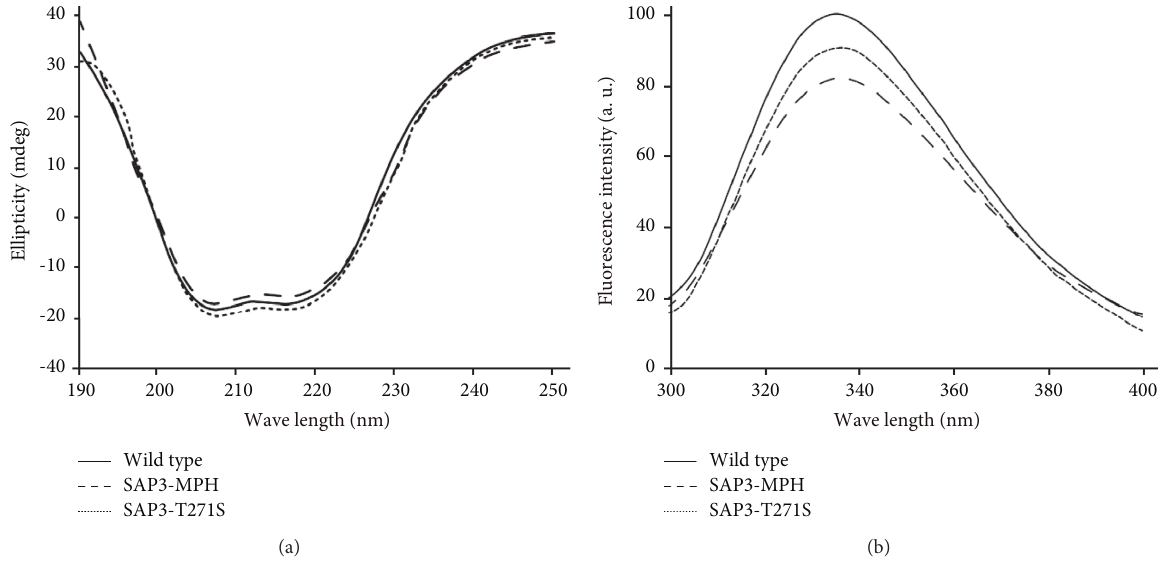
Figure 5: The effect of SAP fusion on the structure of the MPH mutants. (a) CD spectrometry. (b) Steady-state fluorescence